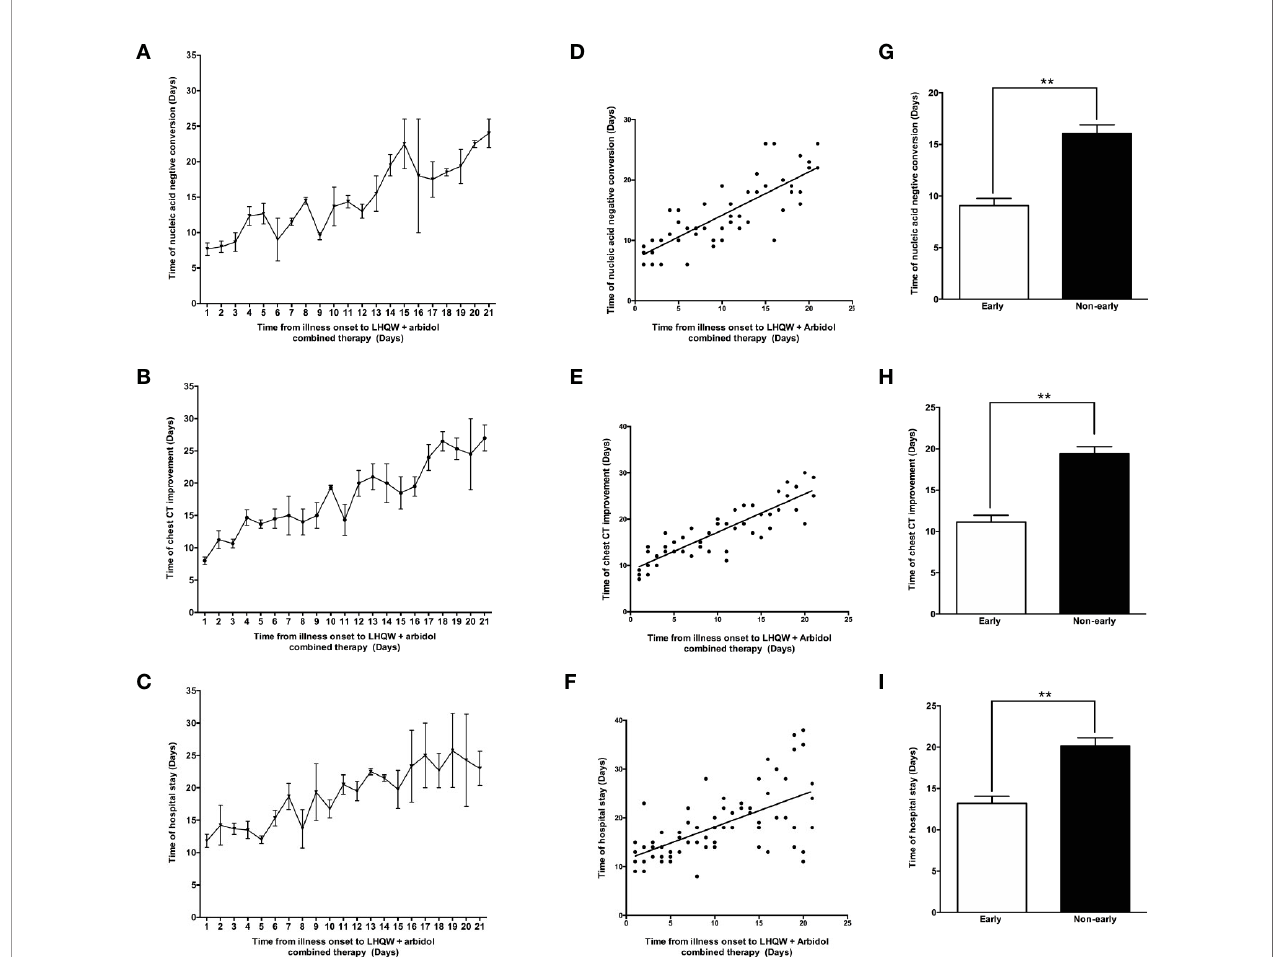
FIGURE 5 | Ef fi cacy of early LHQW + Arbidol combination therapy in patients with moderate COVID-19. The relationships between the time from illness onset to the administration of LHQW + Arbidol combination therapy and time to conversion to nucleic acid negativity (A) , time to chest CT improvement (B) , and length of hospital stay (C) . Correlation analysis of time from illness onset to the administration of LHQW + Arbidol combination therapy with the time to conversion to nucleic acid negativity (D) , time to chest CT improvement (E) , and length of hospital stay (F) . The comparison of time to conversion to nucleic acid negativity (G) , time to chest CT improvement (H) , and length of hospital stay (I) between early and non-early LHQW + Arbidol combination therapy administration. **P < 0.01.